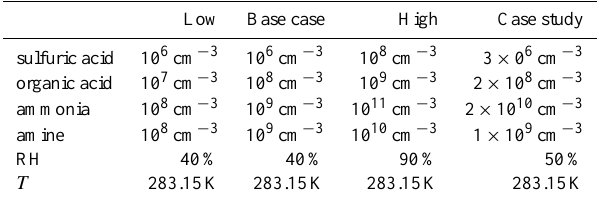
Table 2. Ambient conditions in simulations. Base case values rep- resent typical conditions at Hyytiälä and low and high refer to the limits of the range that was tested (see Appendix A for the estima- tion of these values). The last column gives the ambient conditions used for the case study day